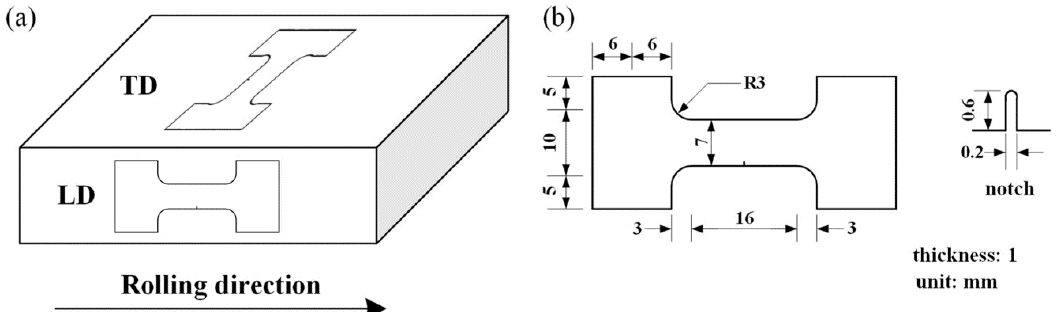
Figure 1. ( a ) Illustration of the longitudinal direction (LD) and the transverse direction (TD) specimen orientations in steel; ( b ) the shape and dimensions of the specimen.